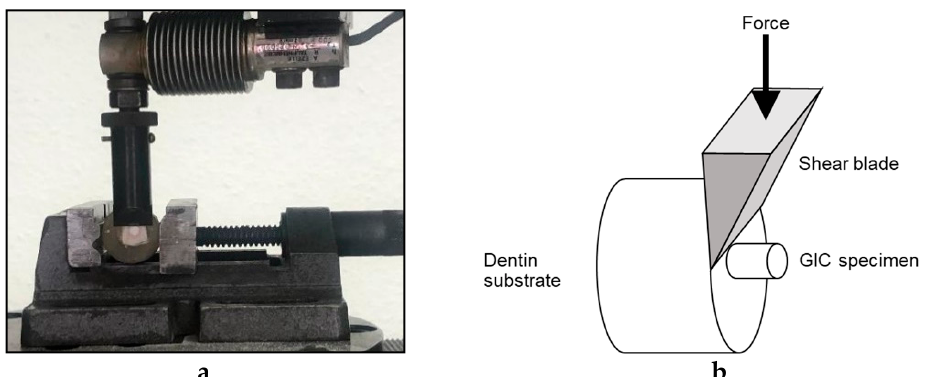
Figure 5. ( a ) Zwick testing machine dislodging GIC specimen; ( b ) Schematic diagram showing shear bond strength testing.